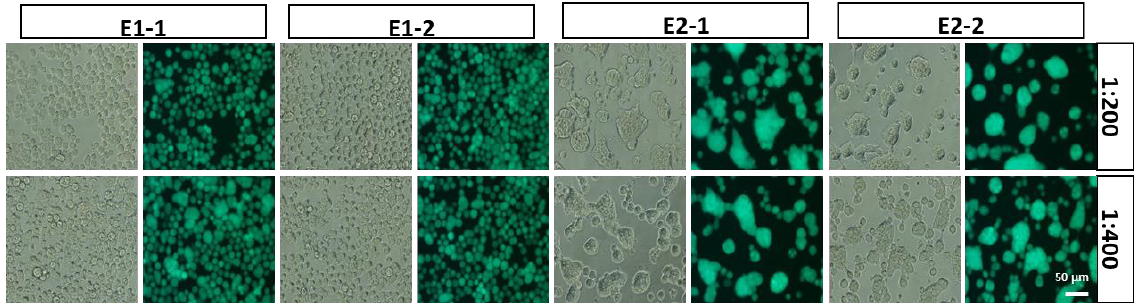
Figure 3. The effects of mAbs against E1 of CHIKV (E1-1 and E1-2, left ) and against E2 of CHIKV (E2-1 and E2-2, right ) on cell fusion inhibition. Sf21 cells were infected with vACMVpH-CHIKV26S-Lir-EGFP at MOI of 1, expressed in Sf21 cells analyzed by the indicated monoclonal antibodies in 200-fold and 400-fold dilutions, respectively. vACMVpH- CHIKV26S-Lir-EGFP-infected Sf21cells were examined under a fluorescence microscope with a FITC channel (lower panel) and bright field (upper panel). The bar represents 50 µm.